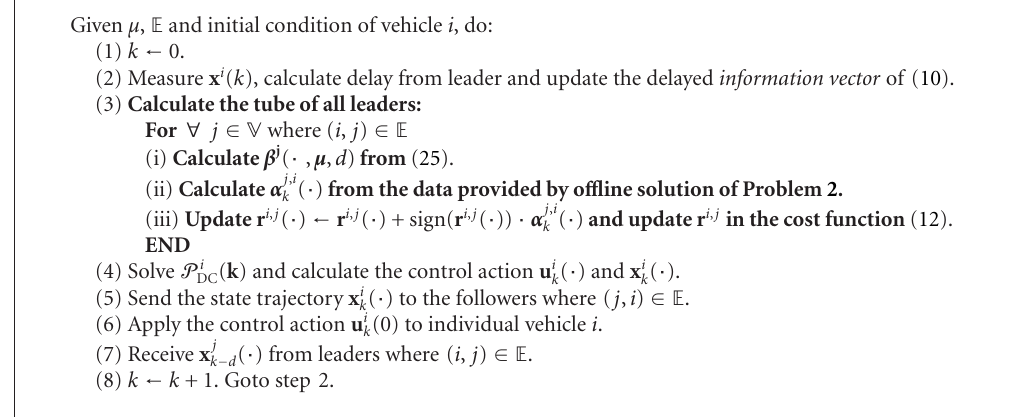
Algorithm 2: DC-DMPC.